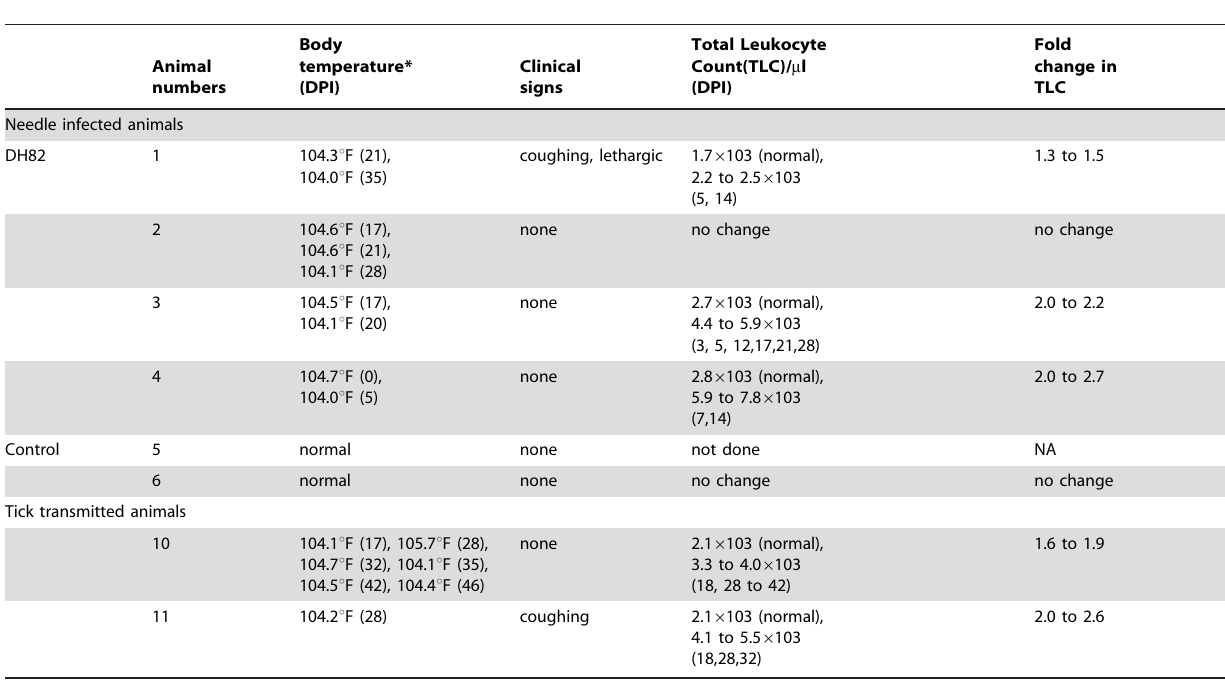
Table 1. Clinical and hematological changes in deer infected with E. chaffeensis